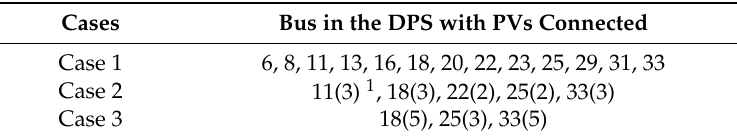
Table 5. PVs’ location.